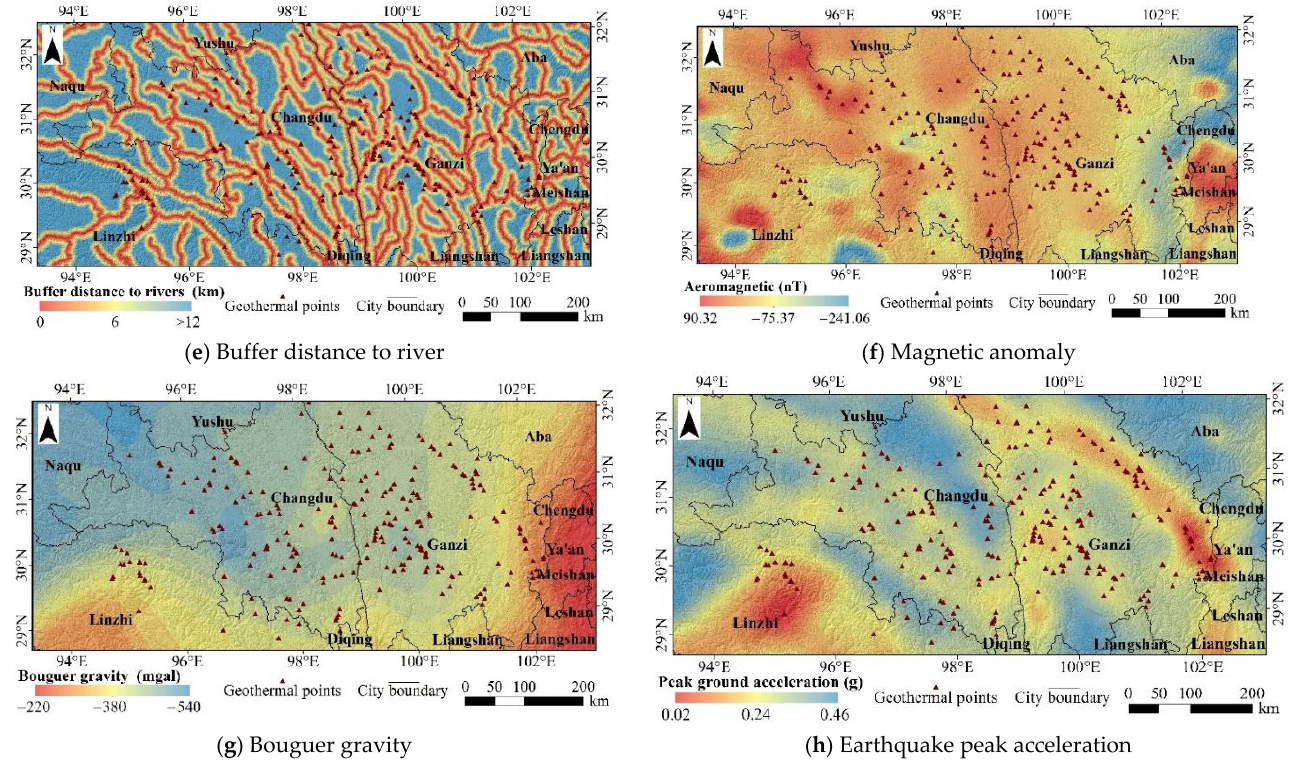
Figure 4. Factor maps.